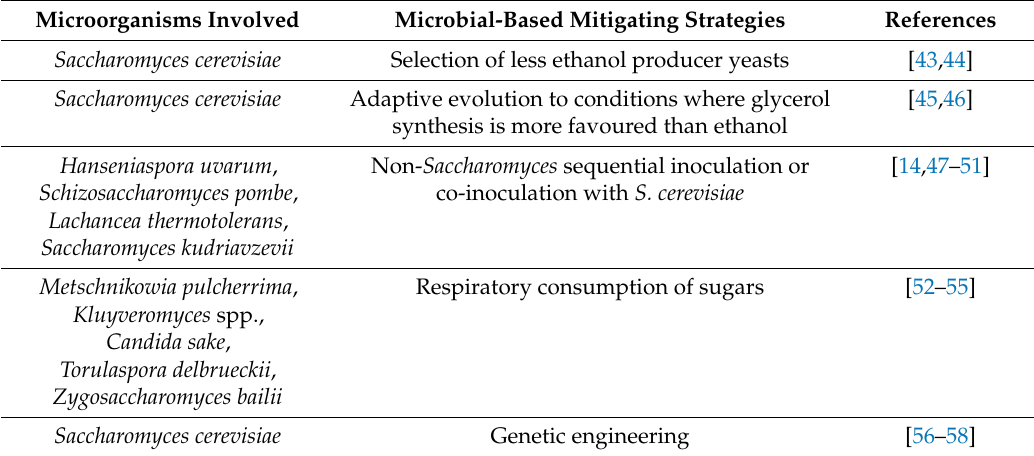
Table 3. A list of studies that propose microbial-based solutions that can have potential applications in mitigating an increased ethanol